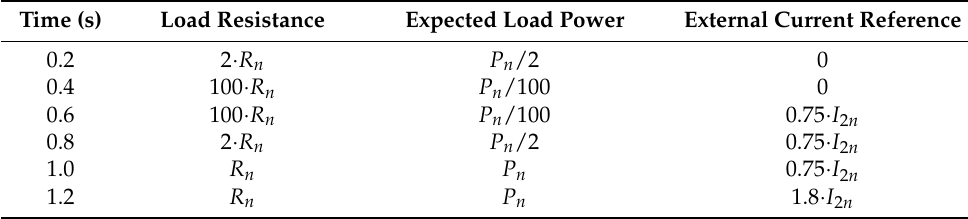
Table 4. Transitions considered in scenario #3